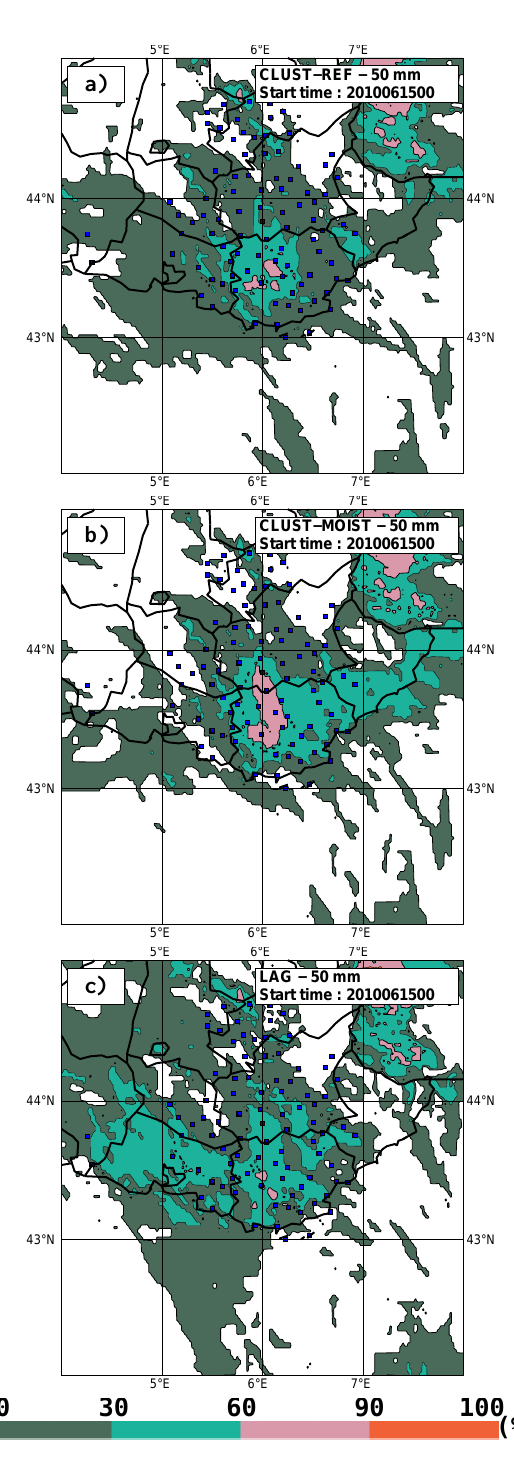
Fig. 12. Var case probability map for the 24-h accumulated precipitation (valid at 06 UTC on 16 June 2010) exceeding 50 mm and for : a) CLUST-REF , b) CLUST-MOIST and d) LAG . The squares are observations (rain-gauges) over the same threshold.